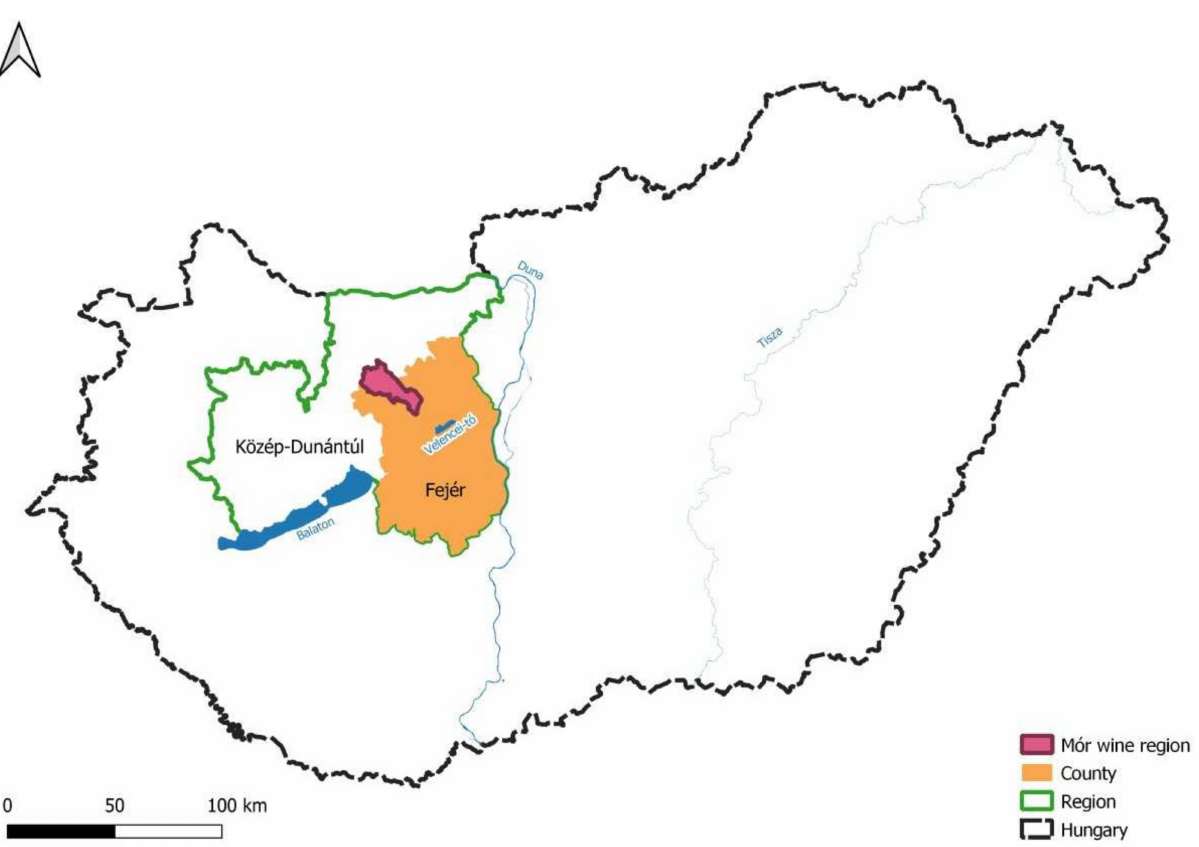
Figure 1. The study area of Fej é r